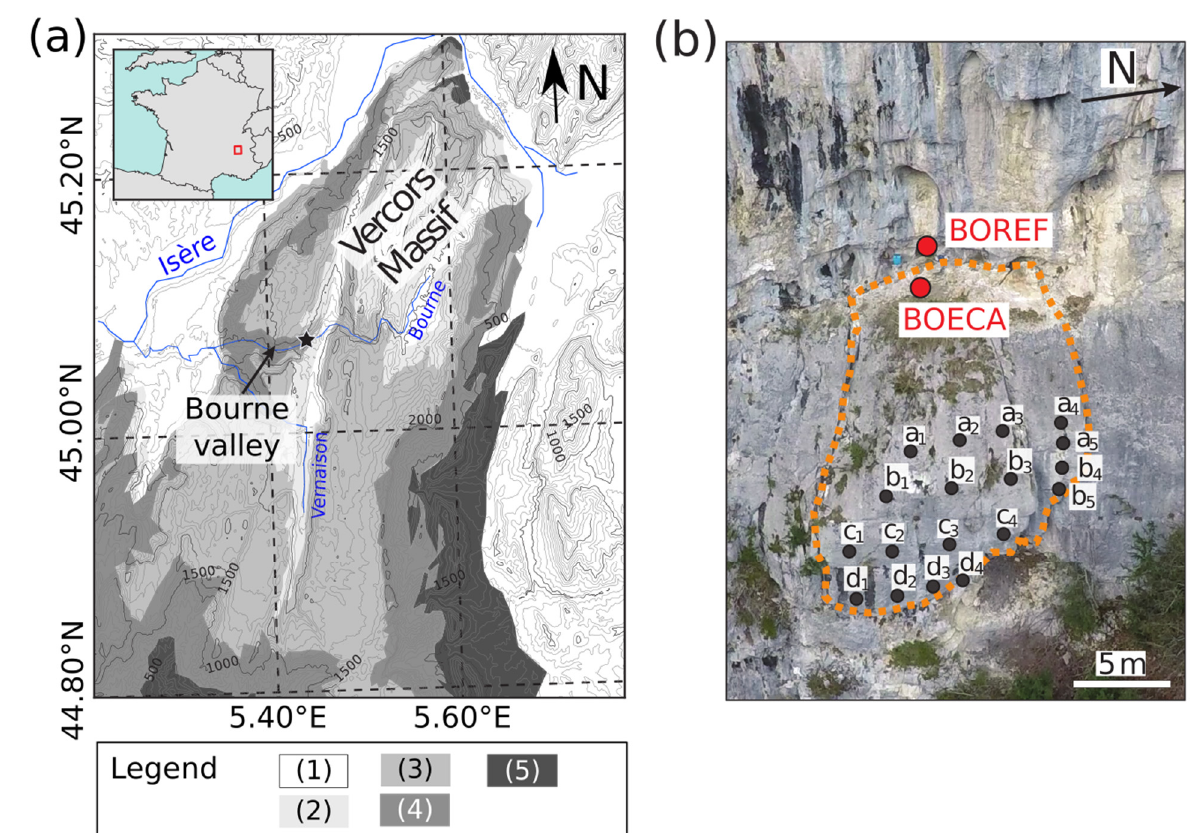
Figure 1. ( a ) Location map and geological settings (adapted from [83]). The study site is located in the Bourne Valley (black star). Geological legend: (1) Quaternary and Tertiary era (present > − 65 Ma); (2) Late Cretaceous ( − 65 > − 110 Ma); (3) Early Cretaceous—Ugonian ( − 110 > − 114 Ma); (4) Early Cretaceous-undifferentiated ( − 114 > − 130 Ma); (5) Jurrasic ( − 130 > − 158 Ma). (2) to (5) belong to secondary era; ( b ) site aerial view. Grey dots show the bolt locations. Sensors BOECA (unstable column) and BOREF (stable reference) are shown with red